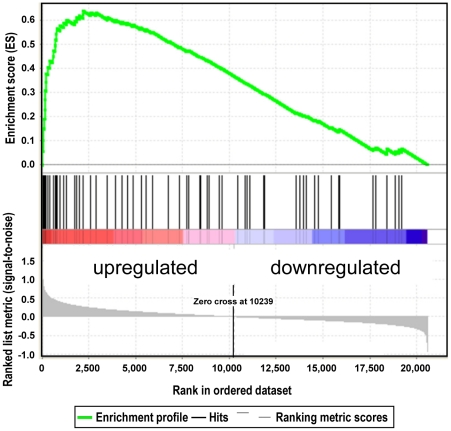
Non-lethal ALA-based PDT stimulates expression of neutrophil activation pathways in tumor cells.Gene set enrichment analysis (GSEA) revealed activation of a set of genes 24 h after non-lethal PDT of all 4 prostate and glioblastoma cell lines (data are shown for PC-3) which is also found to be characteristic for neutrophil activation during wound healing [55]. Upregulation is illustrated by the concentration of the vertical black lines (that represent gene set member positions within the ranked gene list) at the left side of the gene list (“zero cross”; see “waterfall plot” at the bottom of the graph). This distribution leads to a high and significant enrichment score (maximum deviation of the green line from zero; P<0.001 and false discovery rate (FDR) <0.001).